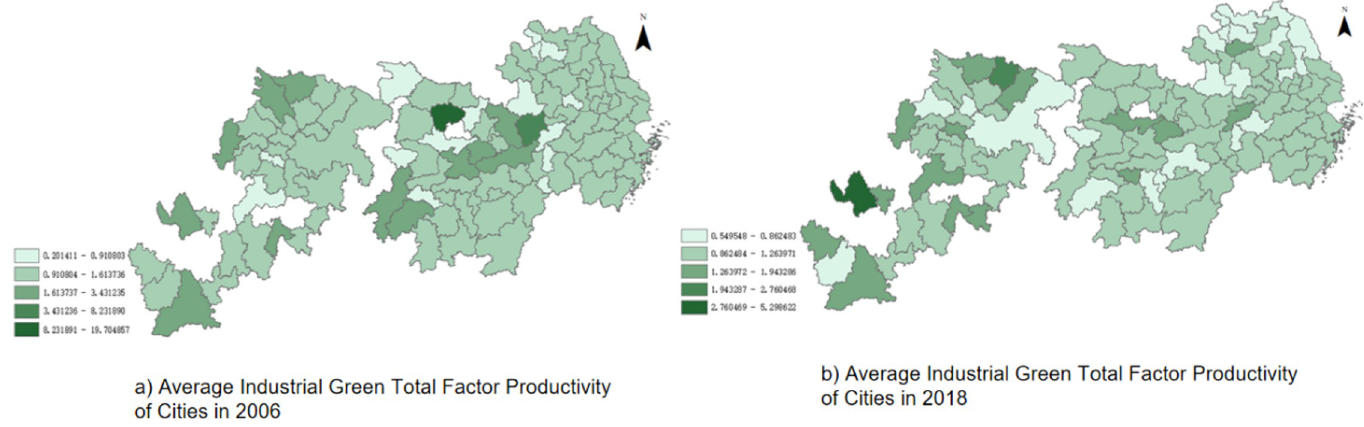
Fig 4. Average green total factor productivity of cities in 2006 and 2018.